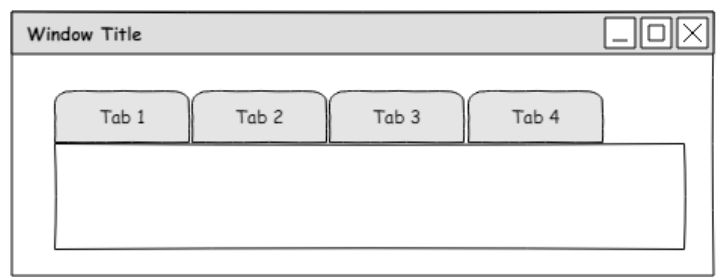
Figure 2. Example of a notebook tab frame.